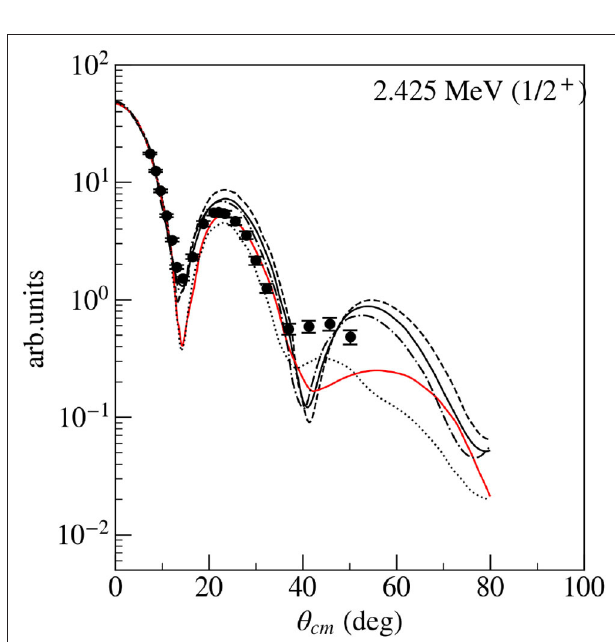
FIGURE 8 | The angular distribution of the 20 Ne( 3 He,d) 21 Na reaction corresponding to the transition to the subthreshold state of 21 Na fitted by combinations of different optical model parameters for input and output channels. OM parameters for input and output channels taken from earlier works produce the black solid curve. The black dashed and dash-dotted curves use the same output channel OM parameters, but the input channel OM parameters were obtained from a fit of the elastic scattering data with two different seeds. Black dotted and red curves are produced as the two previous curves, but with a different OM parameter set for the output channel. For details see ( Mukhamedzhanov et al., 2006).